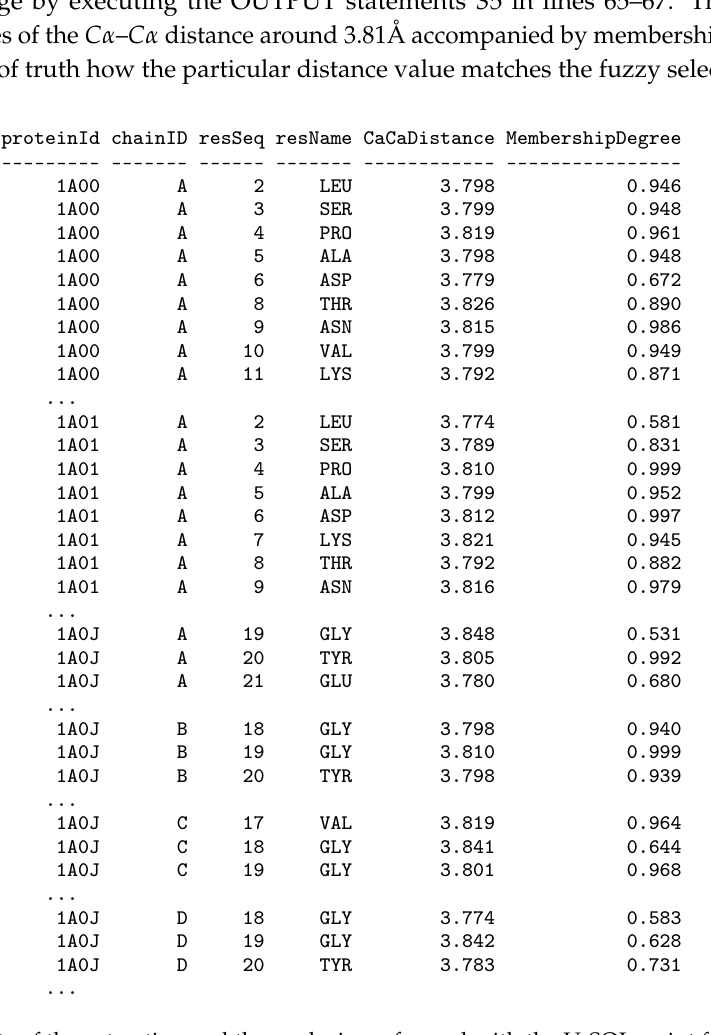
Figure 9. Results of the extraction and the analysis performed with the U-SQL script from Listing 4 showing a part of produced rowset.